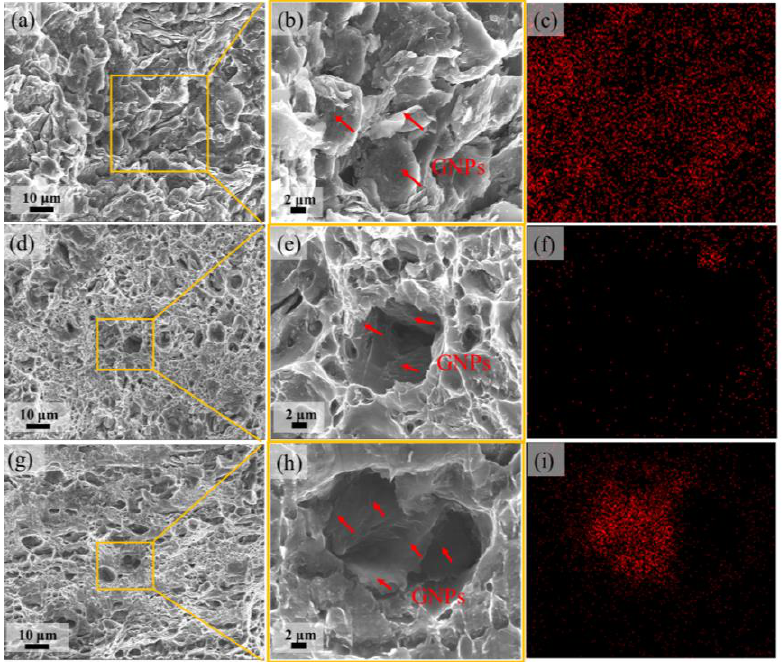
Figure 18. SEM fractography of the composite: ( a , b,c ) hot-pressed; ( d , e,f ) extruded/0° direction; ( g , h,i ) extruded/90° direction.(The red arrow points to GNPs)